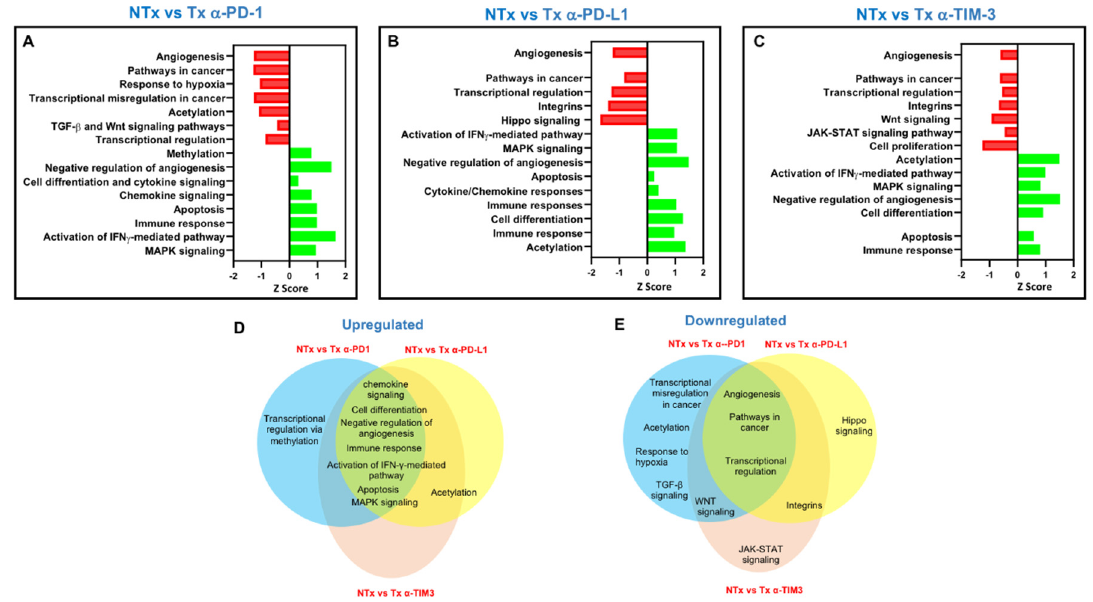
Figure5. Analysesofoverlappingfunctionalpathwaysbetweentheresponseofbreasttumor-infiltrating immune cells to PD-1, PD-L1 or TIM-3 inhibition. The horizontal bars denote the top significantly a ff ected pathways (with a fold of change of > 2 and a p value cuto ff of < 0.05) based on the Kyoto Encyclopedia of Genes and Genomes (KEGG) pathway and DAVID functional annotation analyses for NT (non-treated cells) vs. anti-PD-1 ( A ), NT vs. anti-PD-L1 ( B ), and NT vs. anti-TIM-3 ( C ). Venn diagram summarizing the overlap between functional pathways that were upregulated ( D ) and downregulated ( E ) in the comparative analyses between non-treated and treated cells with either of the immune checkpoint inhibitors (ICIs). Shared pathways are indicated by the overlap between